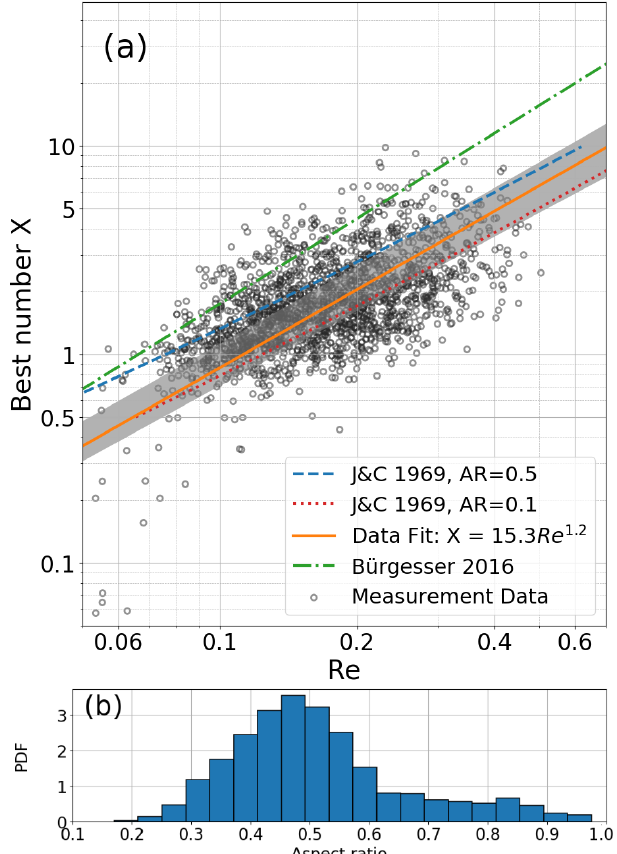
Figure 8. Mean value of D hyd /D maj for each crystal habit for data shown in Fig. 7. Figure 9. (a) Best number as function of Reynolds numbers for investigated falling columnar crystals, N = 1844. Data fit added in orange with error range as gray shading. Parameterization from Jayaweera and Cottis (1969) in magenta and orange, from Bürgesser et al. (2016) in green. (b) Aspect ratio histogram of investigated columnar crystals, mean aspect ratio AR = 0 . 49.